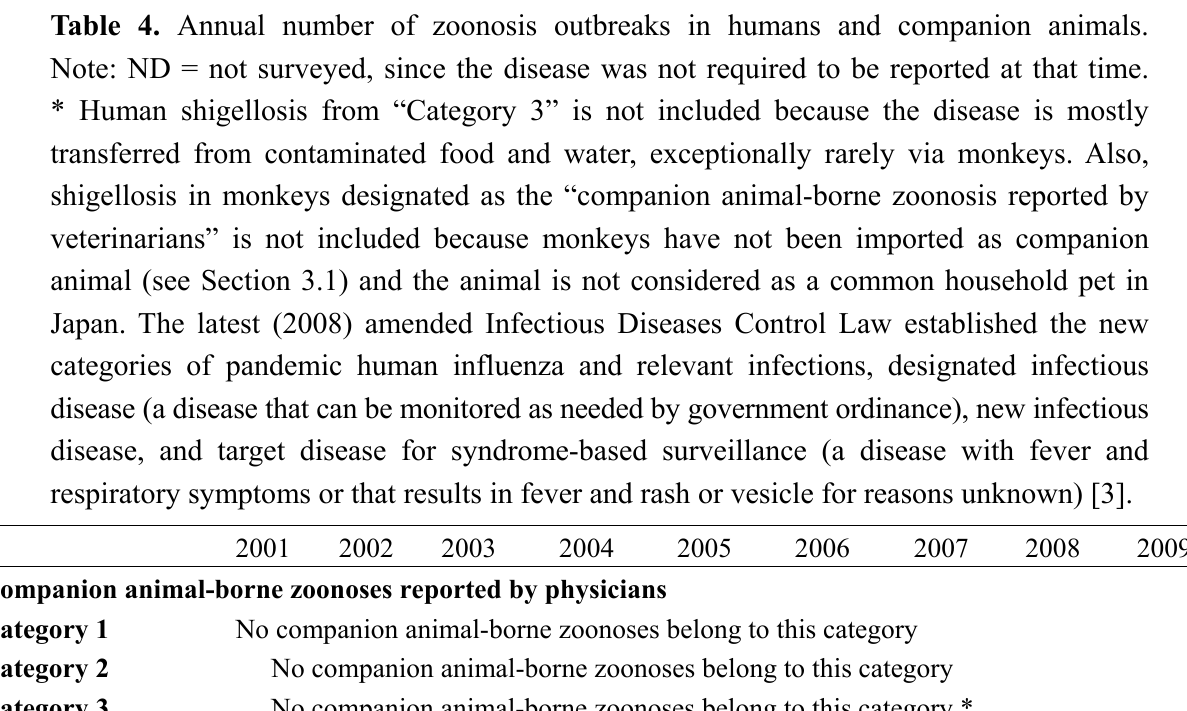
Table 4. Annual number of zoonosis outbreaks in humans and companion